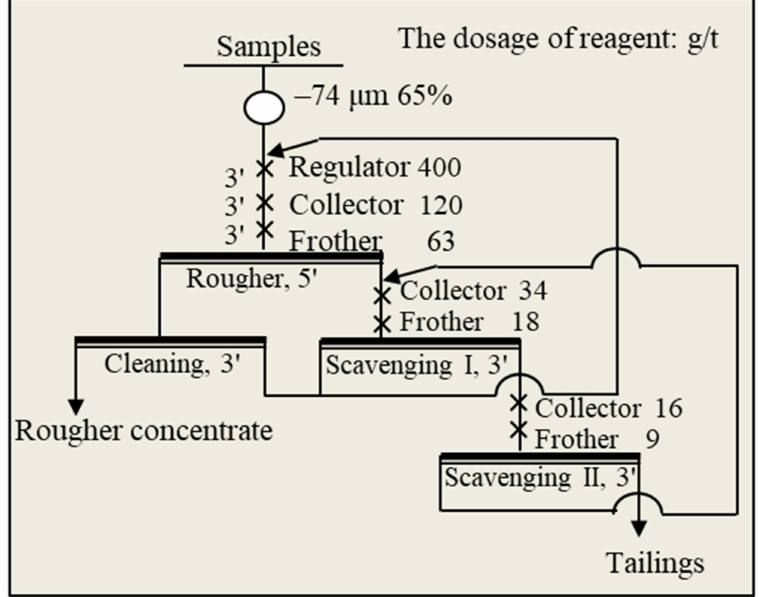
Figure 5. Closedcircuit flowsheets of molybdenite flotation with three types of